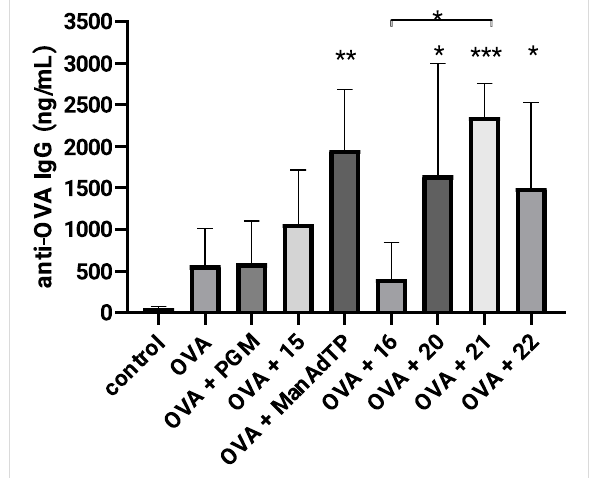
Figure 4: The effect of mannosyl desmuramyl peptides on production of anti-OVA IgG in BALB/c mice immunized with OVA as an antigen. Bar graphs represent average values from individual mice from each group ( n = 5). * p < 0.05, ** p < 0.01 and *** p < 0.001 denote the statis- tical significance in comparison to the control group or groups connected with a